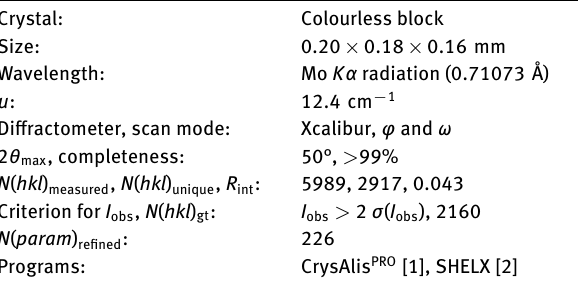
the figure (symmetry code: ′ = 1 − x , y , 1.5 − z ). Tables 1 and 2 contain details on crystal structure and measurement condi- tions and a list of the atoms including atomic coordinates and displacement